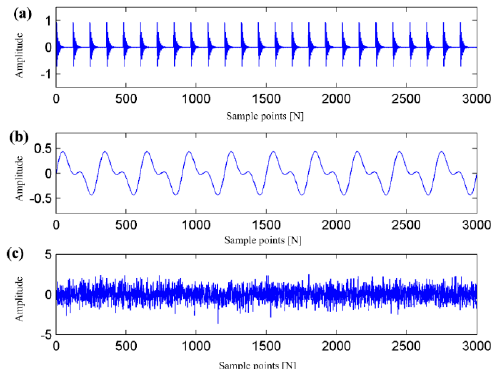
Figure 4. The stimulated fault signals of rolling element bearings. ( a ) The transient impulse fault signal; ( b ) The interference signal; ( c ) The noise signal.